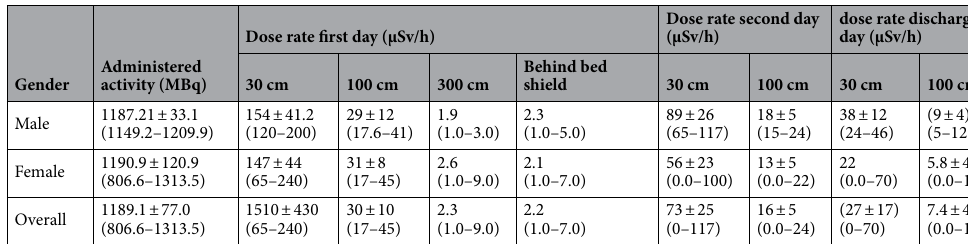
Table 4. Mean, ± Sd and range of patient demographic data for Hyperthyroidism by using Iodine-131.